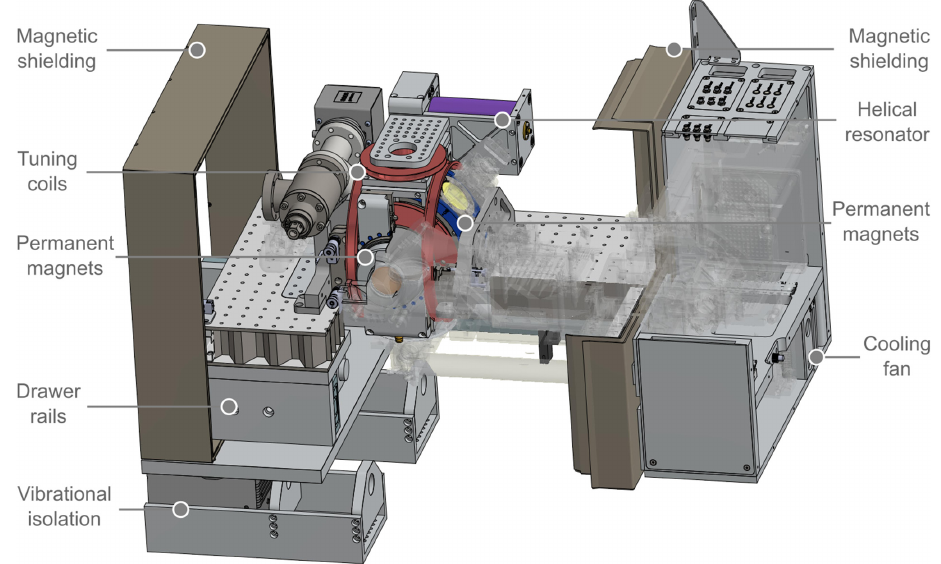
FIG. 3. Schematic of the trap drawer detail, focusing on the trap proper and mechanical components, displayed with extended (opened) drawer. Three sets of compensation coils each with a Helmholtz and anti-Helmholtz coil per holder (red) together with four sets of permanent magnets in Helmholtz (blue, left leader) and Halbach (blue, right leader) configurations define and compensate the magnetic environment. A μ -metal shielding encloses the trap setup except for penetrations allowing electrical and optical access. Active vibration isolation and thick honeycomb-lattice breadboards provide mechanical stability. A fan outside the shielding provides cooling for components close to the